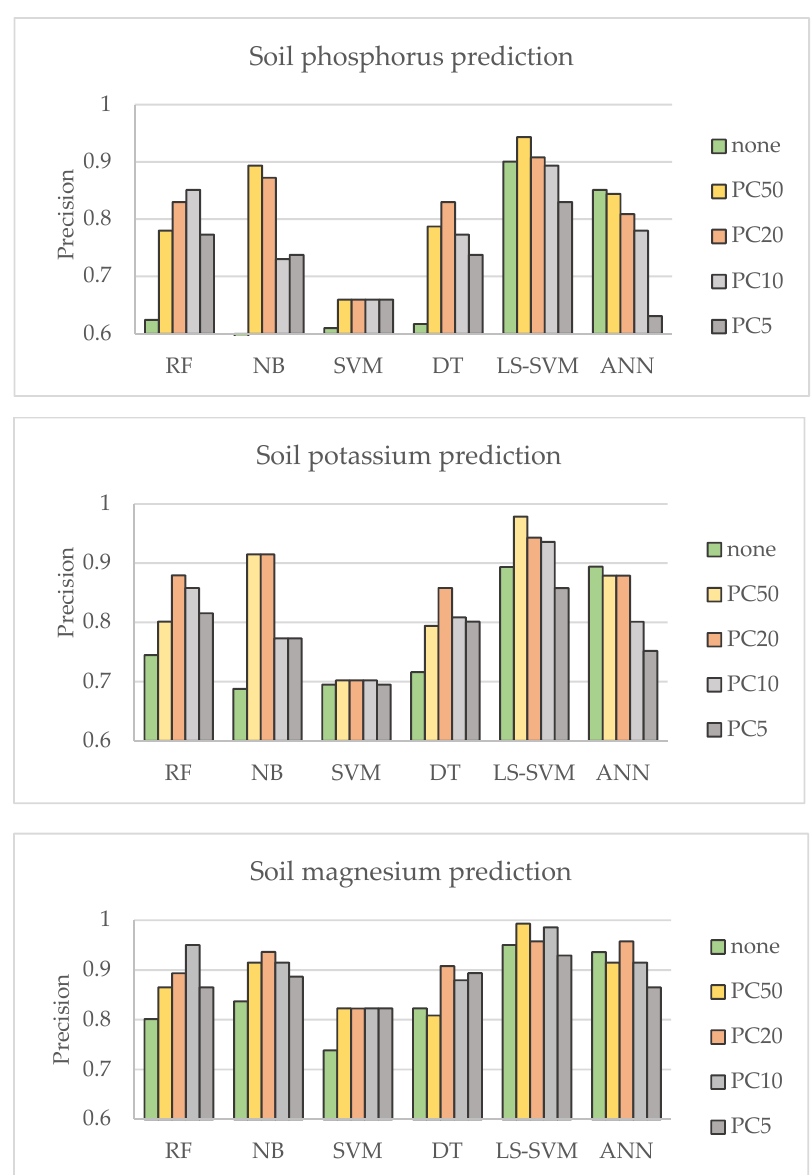
Figure 5. The precision corresponding to the Global soil dataset when a different amount of the principal components is used.